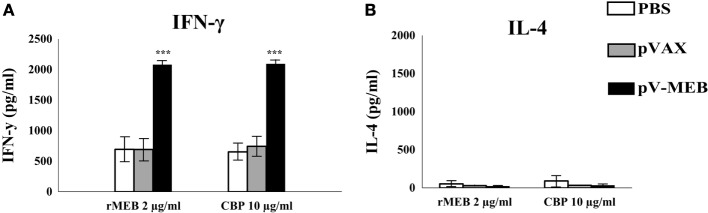
Determination of IFN-γ (A) or IL-4 (B) production. Splenocytes from pV-MEB pVAX or phosphate buffer saline (PBS) groups were obtained 30 days after the last immunization, and were re-stimulated in vitro with 2 µg/ml of recombinant MEB proteins or 10 µg/ml of crude Brucella proteins. Each bar represents the geometric mean ± SD (error bars) of the response in spleen cells from individual mice. ***P < 0.001, statistically significant difference compared to the PBS group.